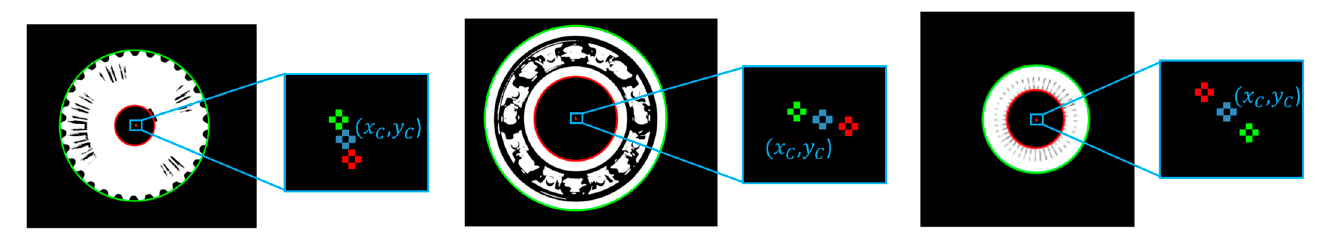
Figure 2. Circumferences found by the Hough transformation on the inner (red) and outer (green) perimeters of the binary picture of the gear wheel, ball bearing and washer. In the right part of each picture the difference in the position of the two centers is highlighted.